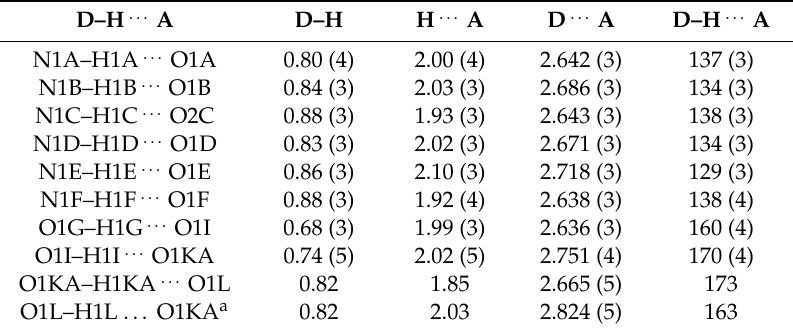
Table 3. Hydrogen bond geometry in 1 (Å, ◦ ).